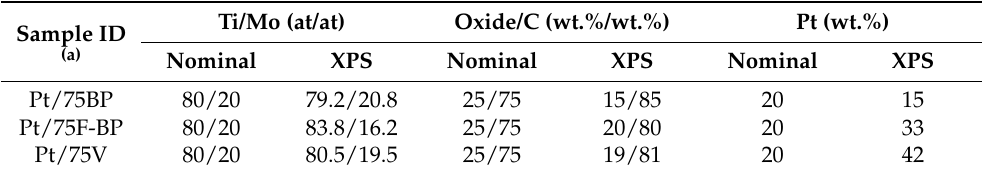
Table 3. Composition of the electrocatalyst samples calculated from XPS results in comparison with nominal